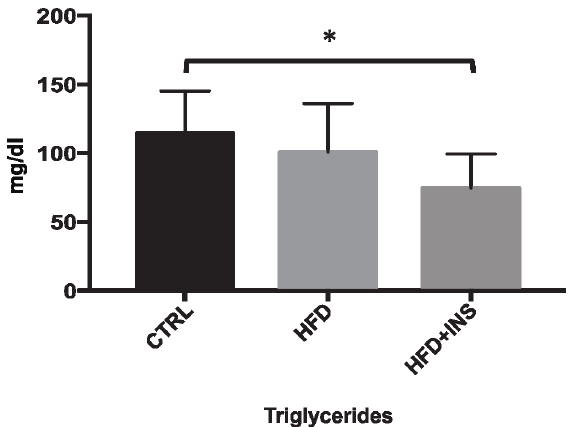
Figure 3 - Fasting triglycerides. CTRL (Control group-regular chow), HFD (rich in fat and low carbohydrates) and HFD+INS (oral insulin gavage). Values are mean ±SD. *p<0,05 CTRL versus